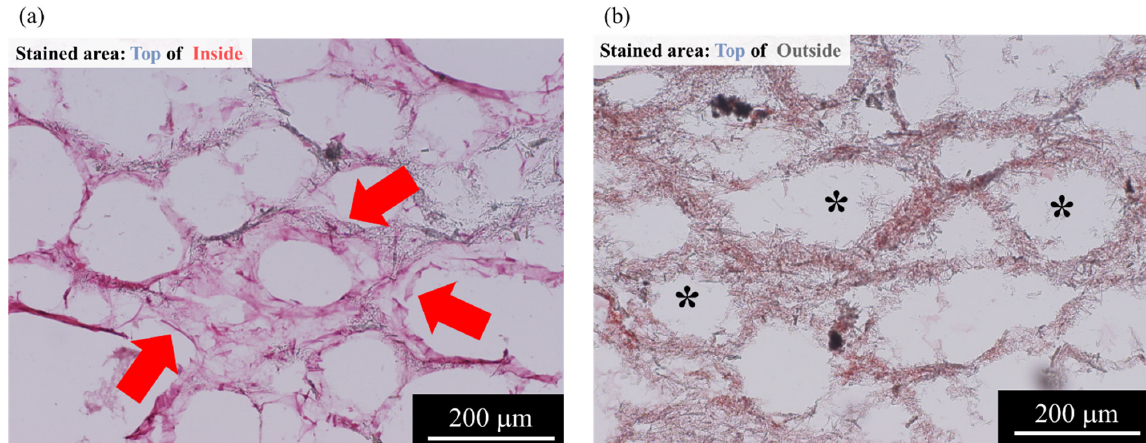
Figure 4. High-magnification histological evaluation using HE and ARS staining for “2w-2w”. ( a ) HE staining and ( b ) ARS staining. Red arrows: Cells located along the AFS skeletons; *: AFS macropores.